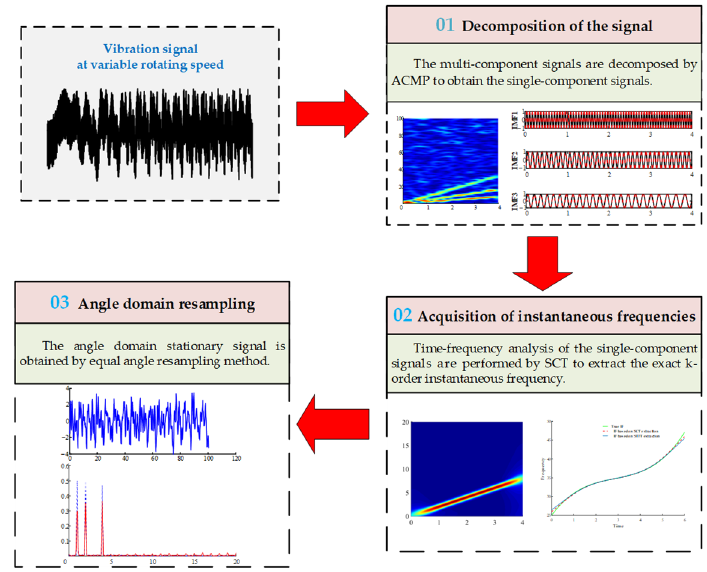
Figure 2. Research